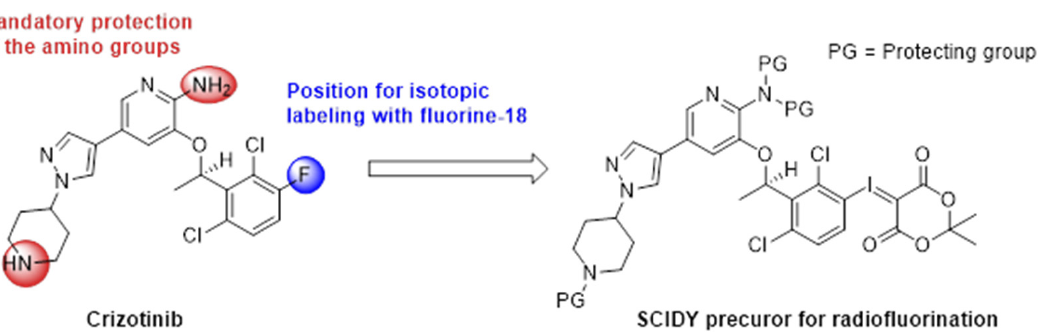
Scheme 1. General scaffold for the SCIDY precursor for isotopic radiolabeling of crizotinib with fluorine-18.